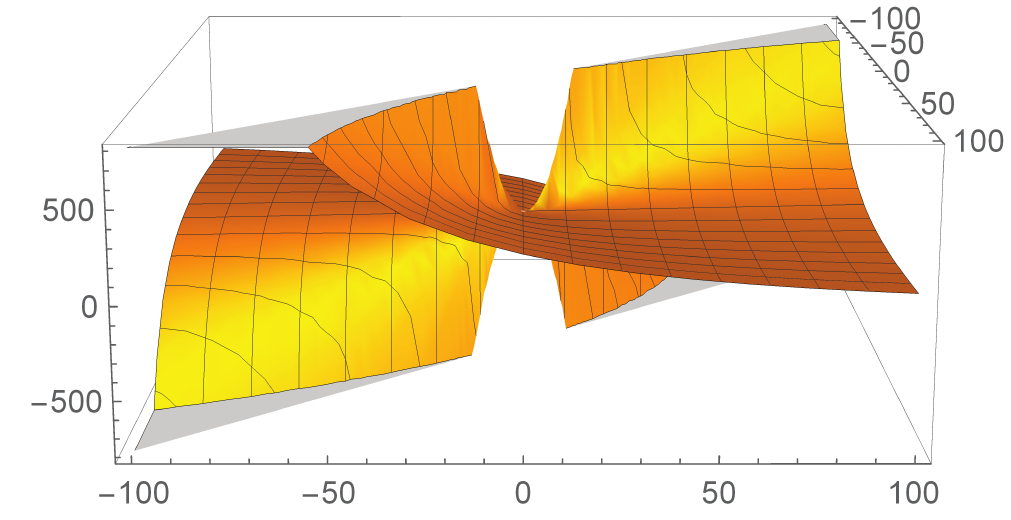
Figure A1. Non-convexity of the χ 2